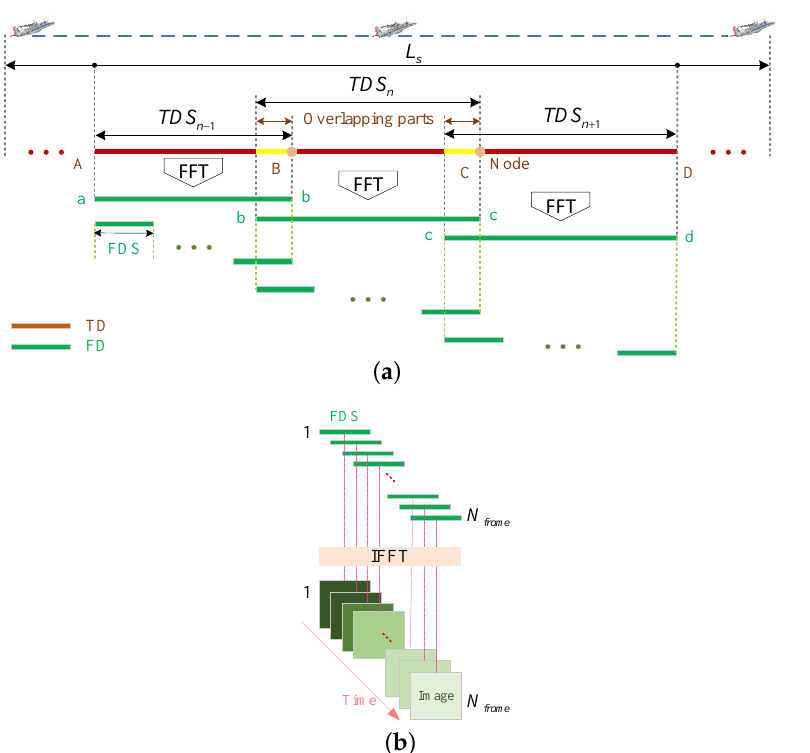
Figure 6. Correspondence between TDS and FDS ( a ). TD means ‘time domain’; FD means ‘frequency domain’. TDS n − 1 , TDS n and TDS n + 1 correspond to those in Figure 5, respectively. A schematic diagram of the formation of multiple video frames ( b ) and N frame represents the total number of FDSs.